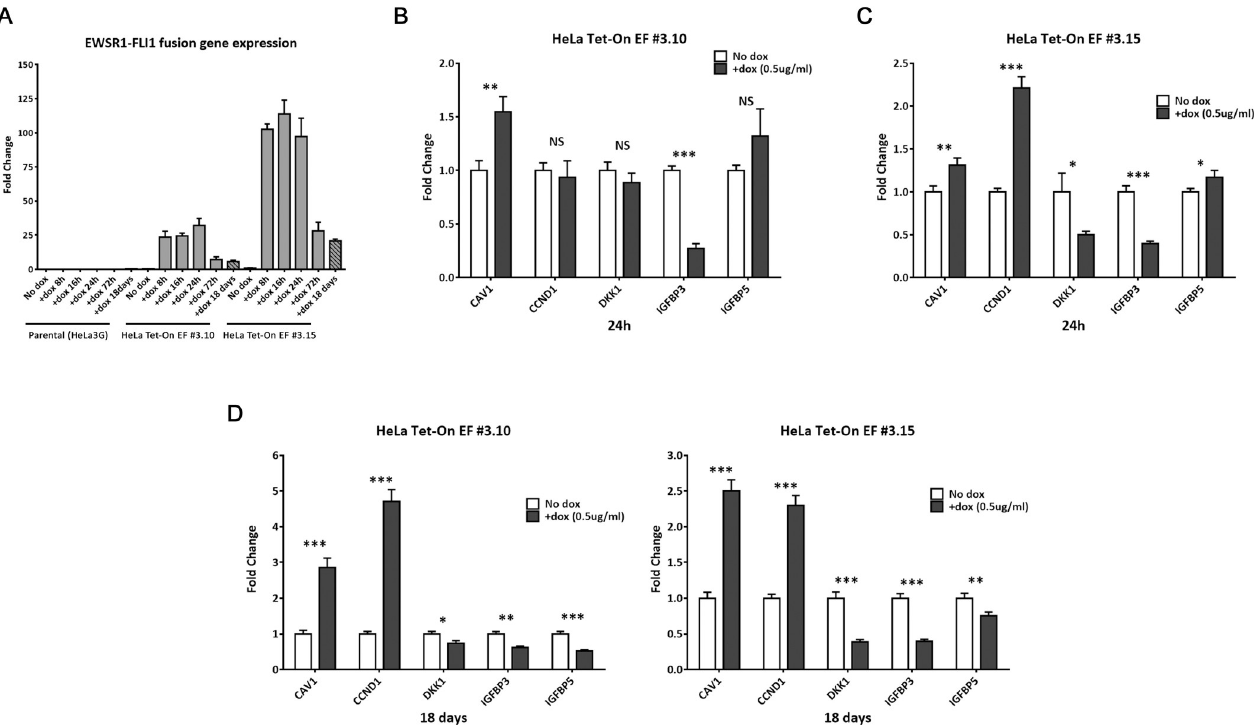
Fig 2. The HeLa model expresses the aberrant transcription factor EWSR1-FLI1. A. EWSR1-FLI1 gene fusion expression analysis in parental HeLa3G cells (control) and two different clones (HeLa Tet-On EF #3.10 and #3.15) in the presence or absence of doxycycline at different time points. B–D. EWSR1-FLI1 up- and downregulated target genes are shown after 24 h and 18 days of doxycycline induction. Values are given as mean ± s.d. of three biological independent replicates. Statistical tests: significant analysis of multiple t-test; ��� , < 0.001; �� , 0.01; � , 0.05; NS, not significant.